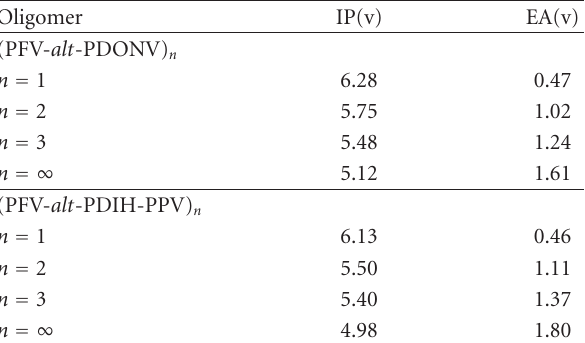
Table 3: Ionization potentials (IPs) and electron a ffi nities (EAs) for PFV- alt -PDONV and PFV- alt -PDIH-PPV by B3LYP/6- 31G(d)(eV) ( n =